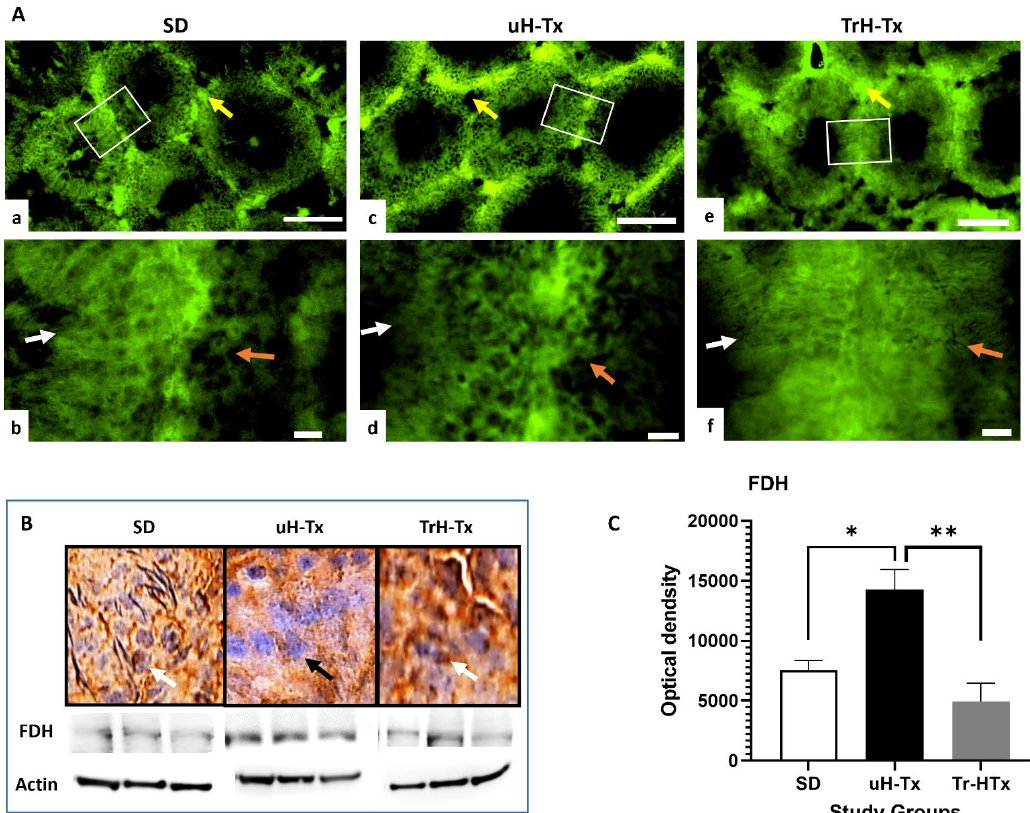
Figure 2. FDH expression in rat testes. ( A ) Immunofluorescence staining for FDH in SD ( a , b ), untreated H-Tx (uH-Tx) ( c , d ) and treated H-Tx (TrH-Tx) ( e , f ) rats (( a , c , e ) at 100 × , scale bar = 200 µ m and ( b , d , f ) at 400 × , scale: 25 µ m). White boxes in ( a , c , e ) are regions enlarged in ( b , d , f ). Yellow arrows in ( a , c , e ) indicate intertubulular tissue regions with concentrations of FDH. FDH shows a variable pattern between different tubules in all three groups with cytoplasmic localisation (white and orange arrows indicate tubule tissue-lumen margins in adjacent tubules). ( B ). Immunoperoxidase staining shows nuclear expression of FDH in SD rat testes (white arrow point to positively stained nuclei in both SD and TrH-Tx) whereas, uH-Tx has little or no nuclear localisation (black arrow points to negatively stained nuclei). TrH-Tx shows similar staining to SD (magnification 400 × , scale: 25 µ m). Western blot analysis of total tissue lysate shows increased FDH protein in uH-Tx compared to both SD and TrH-Tx, shown in graphical format in ( C ) (ODs SD: 20,437, H-Tx: 27,660, TrH-Tx: 19,493, *: p ≥ 0.05, **: p ≥ 0.01). The results are representative of n = 4–6 rats with a minimum of three sections from different locations of each testis and three repeated